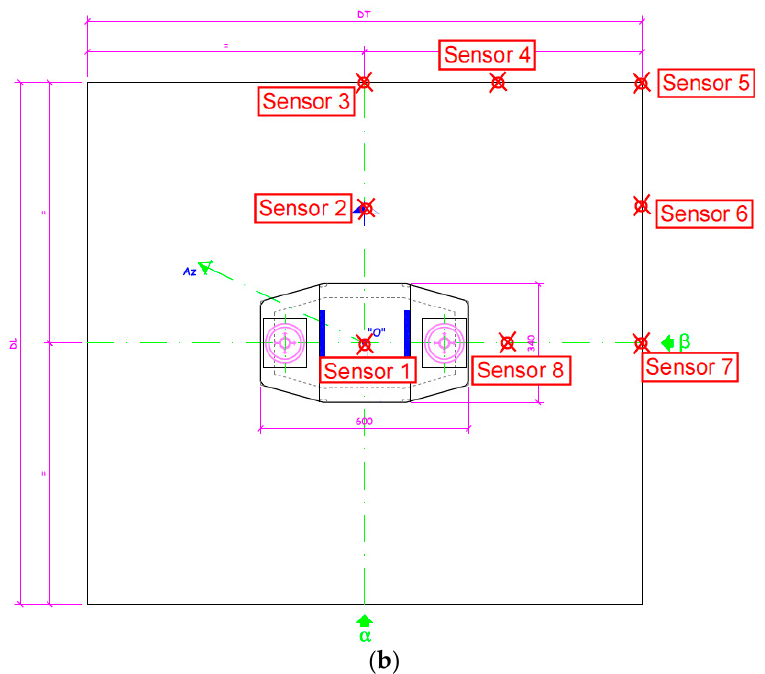
Figure 12. ( a ) Construction element and ( b ) location of sensors.